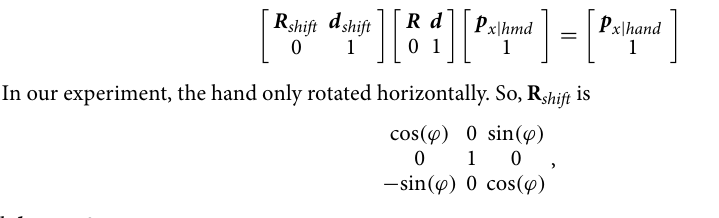
where the matrix consisting of R and d is transformation matrix, representing the physical transformation between hand tracking sensor and HMD. The hand tracking sensor is attached to the front of the HMD without rotation. R is a 3 × 3 unit matrix where there is no rotation of sensor axes, and d is the relative position of the hand tracking sensor from the HMD. Second, the experimental condition is given by R shift and d shift , which indicate rotation matrix and translation vector for hand shift, respectively. The hand shift was applied using the following equation: